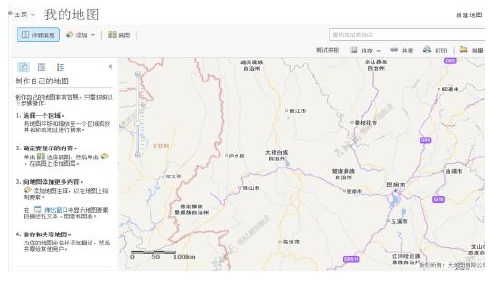
Figure 5.2. Portal of spatiotemporal cloud platform